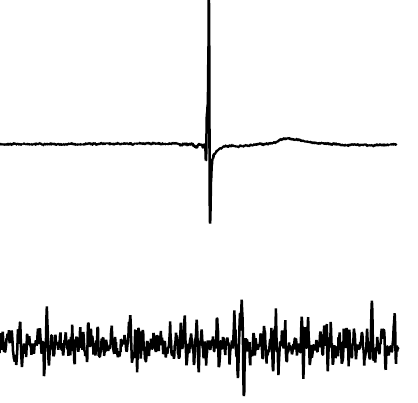
Figure 1. A measured raw data set of an MEP (upper) and interference EMG (lower) shows the different properties of a transient signal and a continuous signal. The upper graph shows a compound muscle action potential (CMAP) curve induced by a transcranial magnetic stimulation (TMS). The lower surface EMG recording shows the stochastic properties of an interference EMG during a slight voluntary contraction. The time scale shows a signal duration of one second and an amplitude of ±1.75 mV. Signals belongs to the same subject with the same electrode application on the extensor carpi radialis (ECR).